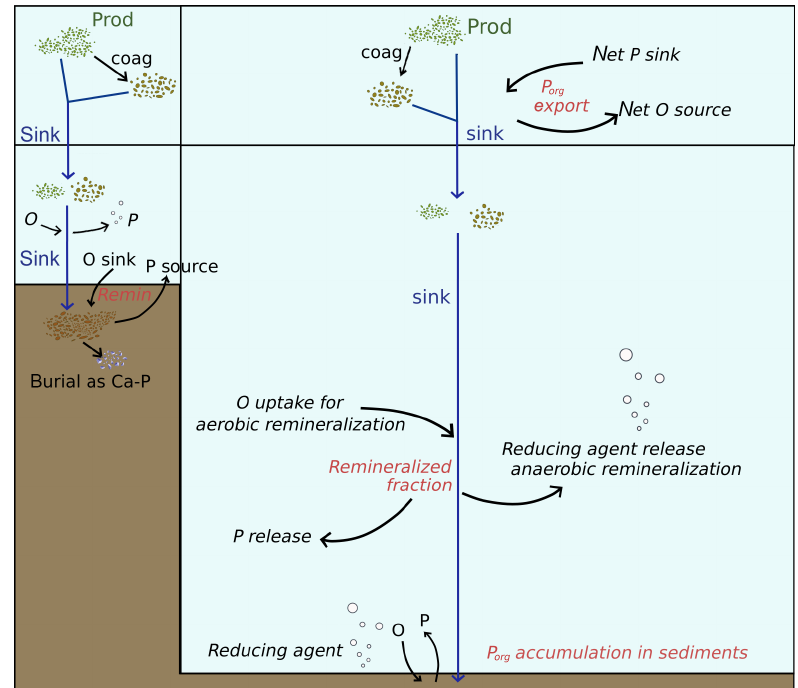
Figure 2. Representation of the physical and biogeochemical fluxes affecting the P org cycling in the model. Even though some processes (such as burial as Ca–P) are here represented in detail only in one box, the set of biogeochemical processes regulating the P org dynamics in shelf sea and open ocean (both water column and sediments) is the same, as described in Sect. 2.2.